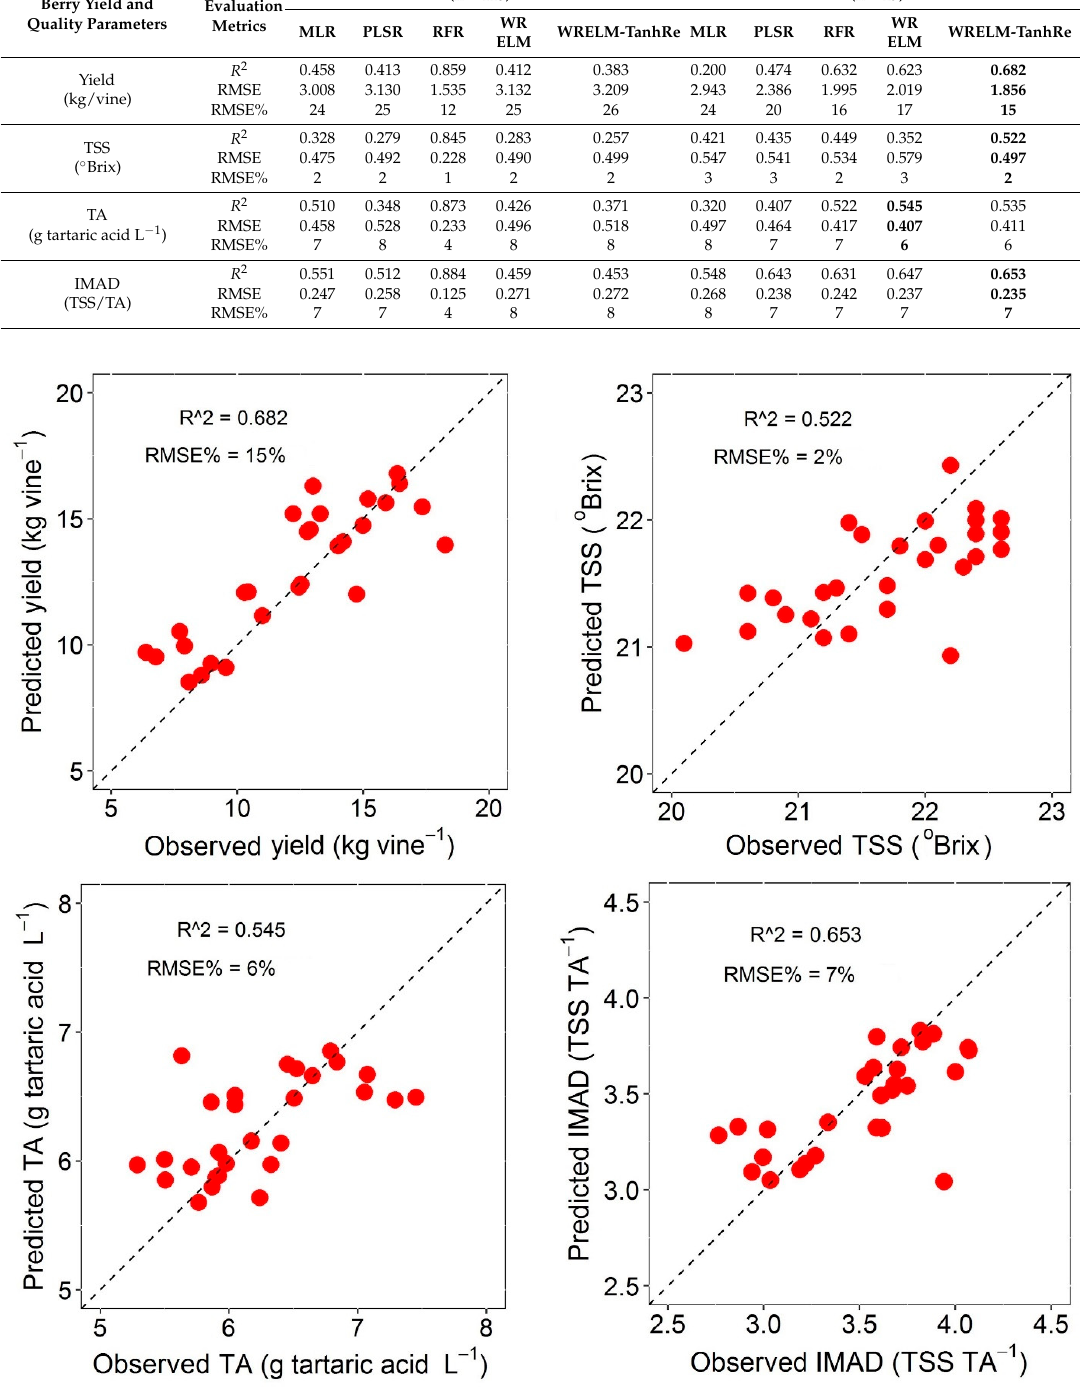
Figure 6. Observed versus predicted grapevine berry and quality parameters with the best ELM-based models using independent validation dataset.